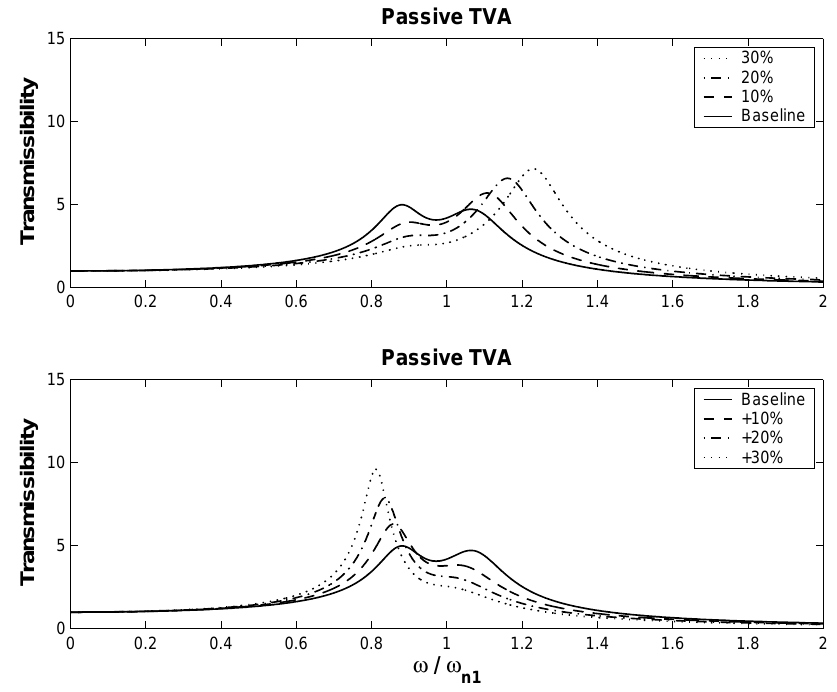
Fig. 3. Peak transmissibility variation of the passive TVA: (a) decreasing the primary mass (b) increasing the primary